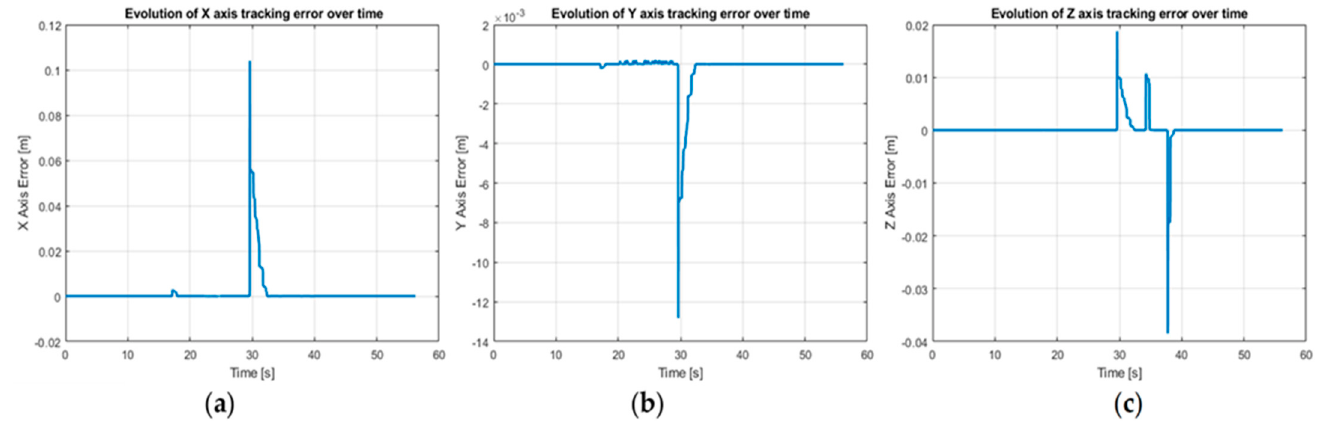
Figure 26. Tracking errors for RM Cyton picking object trajectory on: ( a ) X axis, ( b ), Y axis, ( c ) Z axis.